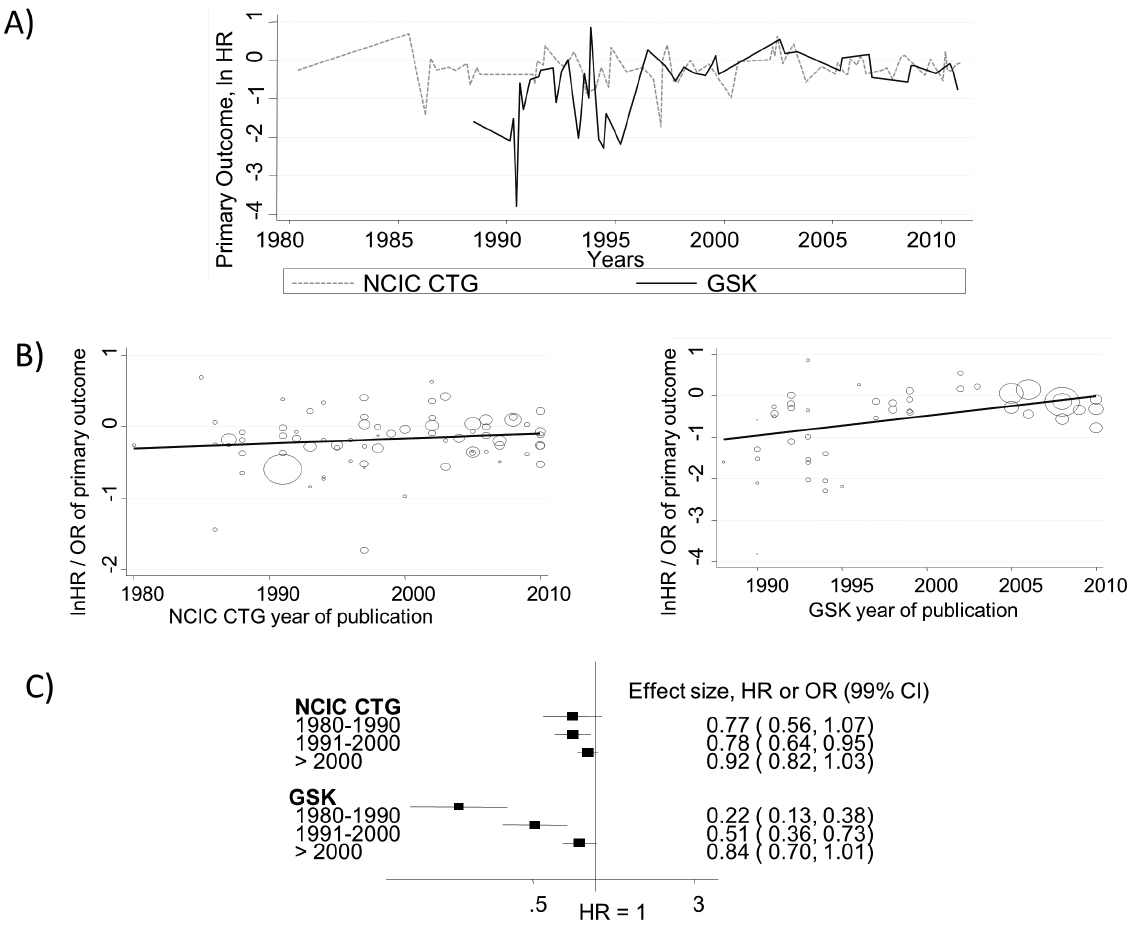
Figure 10. Assessment of the pattern of treatment successes over time. A) Time series analysis of treatment effect (natural logarithm of hazard ratio [ln HR]). Data are consistent with ‘‘white noise’’ pattern indicates no significant autocorrelation between studies carried out at various time intervals. An ln HR less than 0 indicates superiority of new treatments; greater than 0, superiority of standard treatments. B) Meta-regression analysis. The results shows a significant trend toward HR=1 (logHR=0) over time in the GlaxoSmithKline (GSK) cohort. That is, the average effect size of treatments decreased over time [by 38% per decade (=exp (0.48)=1.62)] For the National Cancer Institute Canada Clinical Trials Group (CTG) cohort there was no statistically significant change in the treatment effect over time. R 2 =24.48% for GSK i.e. the model accounted for about 25% of the observed variation in the results while R 2 was virtually zero in the CTG cohort. C) Meta-analysis stratified according to time periods. The results confirm the findings of meta-regression. Vertical lines indicate lines of no difference between new and standard treatments. Note that a ‘‘no difference’’ result can be obtained when treatments are truly identical, or when experimental treatments are as successful as standard treatments (i.e., sometimes new treatments are better and sometimes standard treatments are better). Squares indicate point estimates. Horizontal lines represent 99% confidence interval (CI).